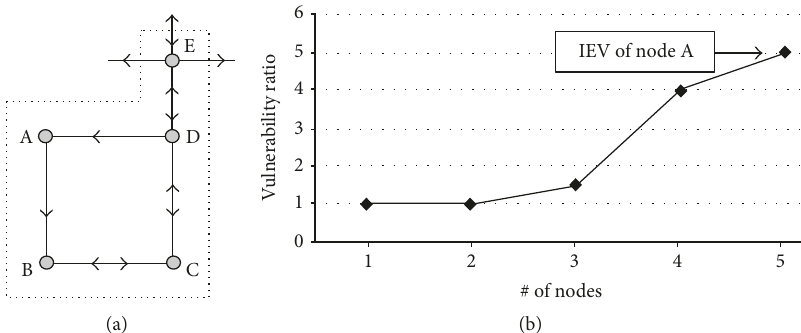
Figure 2: The procedure of searching for the IEV of anchor node A: (a) when the region includes five nodes, the ratio reaches its maximum and node A’s IEV is derived; (b) the relationship between node A’s inbound vulnerability ratio and the number of nodes in the search region.